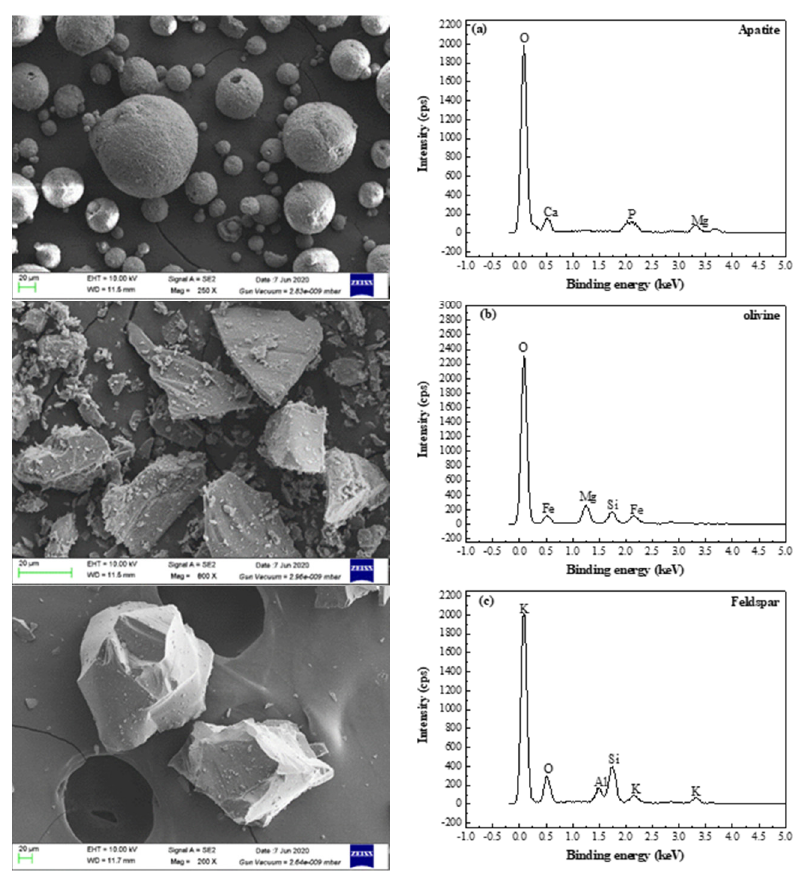
Figure 13. XRD diffractograms of the P–Containing V–Ti magnetite tailings.